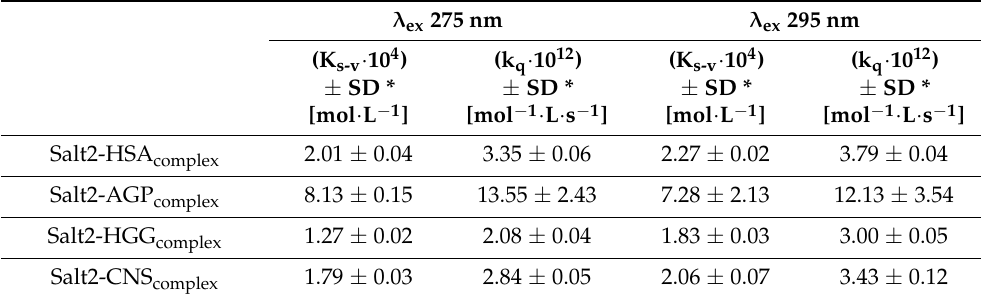
Table 4. Stern–Volmer constants (K S-V ) and bimolecular fluorescence quenching rate constants (k q ) of the studied systems ( λ ex 275 nm and λ ex 295